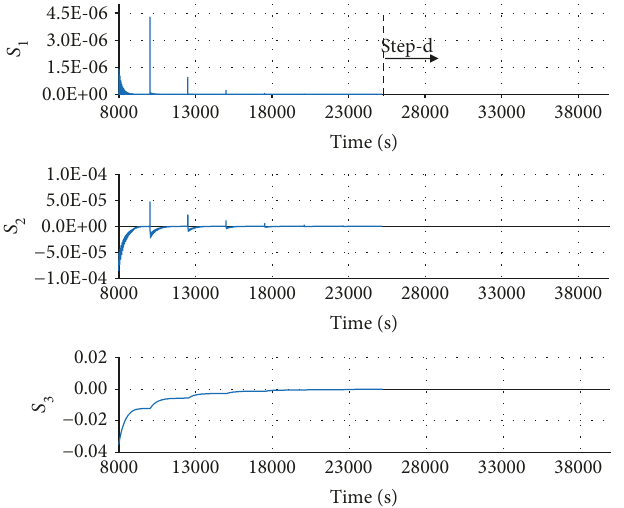
Figure 9: Time history of the three invariant manifolds after fi rst achieving S